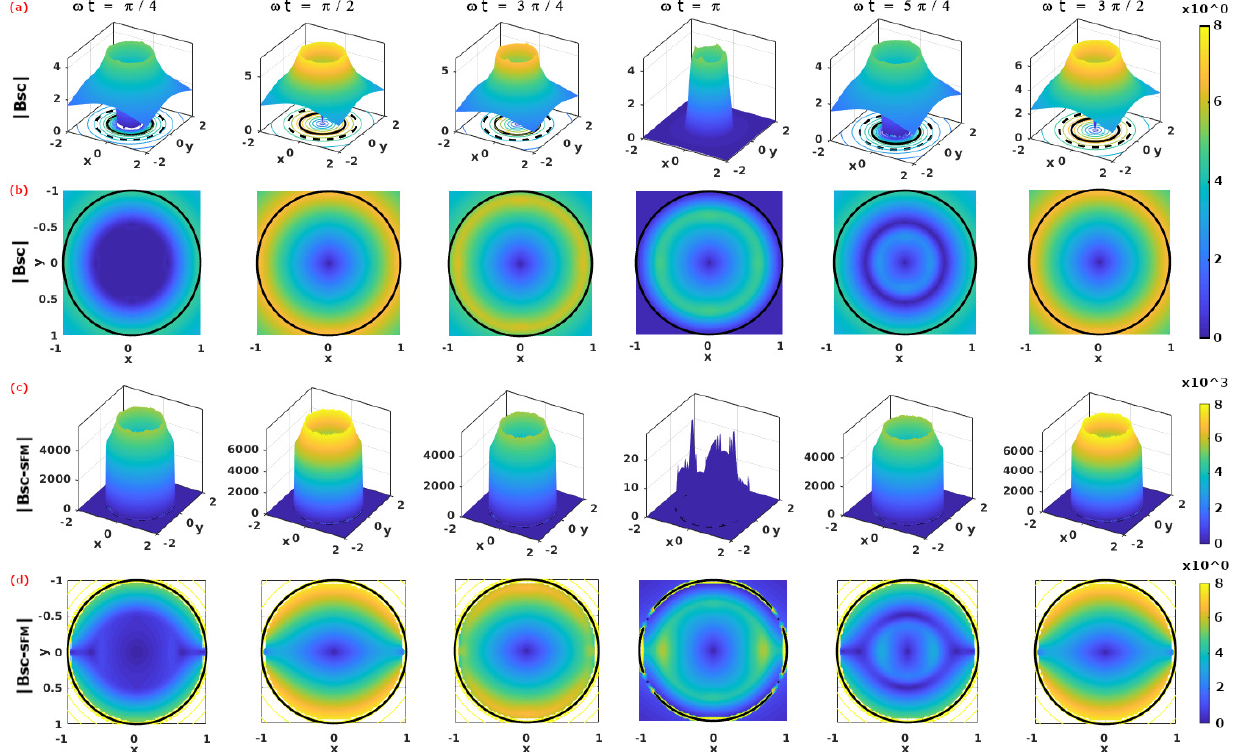
Figure 2. Dynamics of the norm of magnetic flux density | B | in units of ( µ 0 /4 π ) J c R SC in ( a ) an SC wire (without SFM sheath) of radius R SC = 1 (in arbitrary units) whose cross section lies on the plane xy and which is subjected to an applied transport current I tr = I c sin ( ω t ) . ( b ) shows the same distribution of field but in a 2D representation that focus on the local flux dynamics inside the SC, | B SC | . Analogously, ( c ) shows the flux distribution | B SC − SFM | for the SC-SFM metastructure with R SFM = 1.5 R SC and µ r = 46, where the impact of the SFM on the SC can be seen clearer in the 2D representation shown in ( d ), that is, the bottom pane of subplots. The time interval between columns is ∆ t = ( π /4 ) ω − 1 , such that the dynamics shown between the second column ( ω t = 3 × π /2 ) and last column ( ω t = π /2 ) represents the minimum hysteresis period for the calculation of AC Losses, in accordance with the distribution of profiles of current density shown in Figure